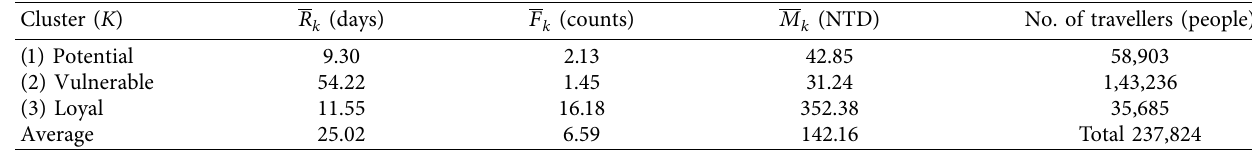
Table 13: Clustering results by K -means for 2019 Q 1.